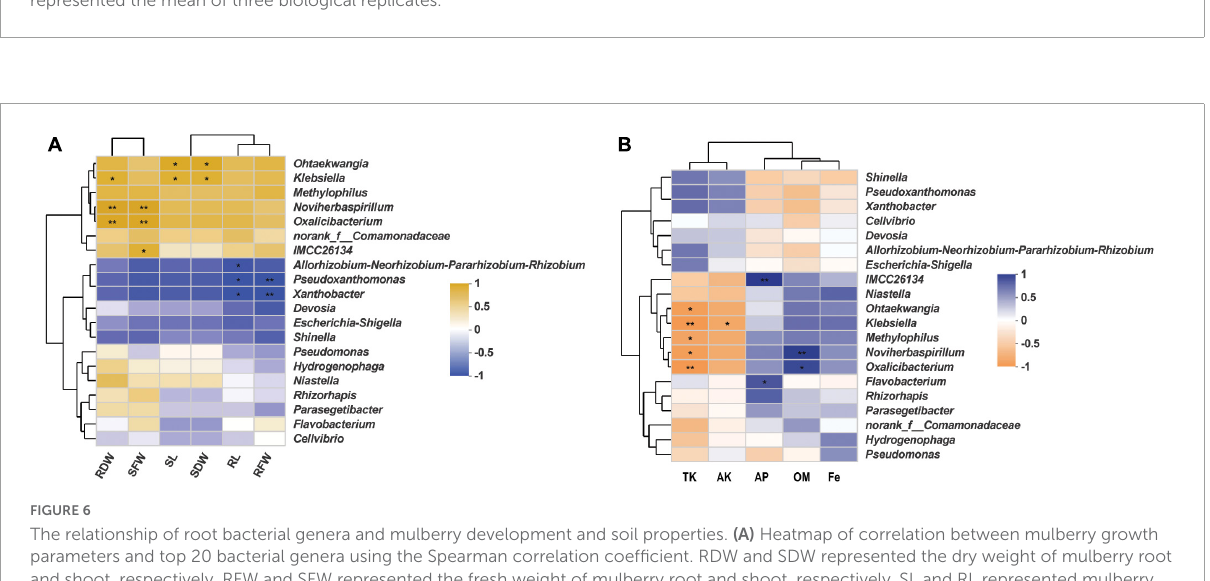
FIGURE5 Effect of K. aerogenes HGG15 strain on mulberry associated bacterial communities. (A) Principal coordinate analysis of bacterial communities in the rhizosphere soil, root and stem of mulberry based on Bray–Curtis distances. (B) Composition of bacterial communities in the rhizosphere soil, root and stem of mulberry at order (left) and genus (right) level. Taxa with an abundance < 0.01 were included in “others.” Each column represented the mean of three biological replicates.